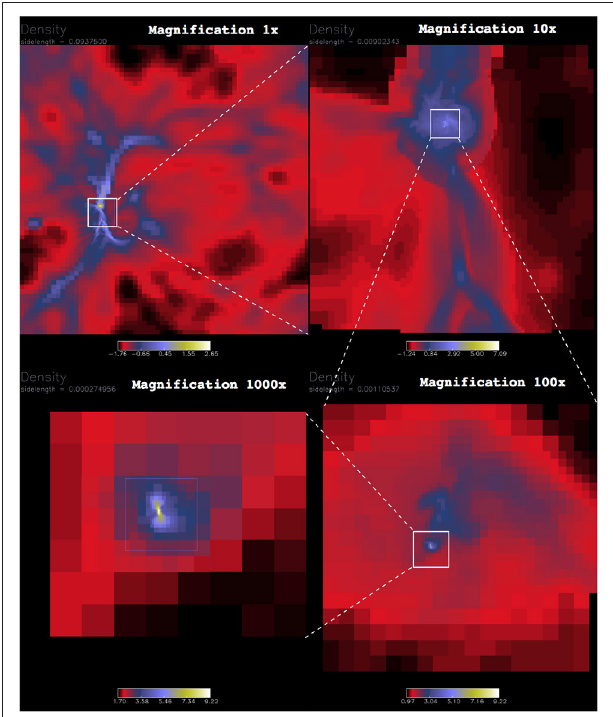
FIGURE 2 | The first published zoom-in image from a cosmological AMR simulation of primordial star formation. Reproduced by permission of Figure 1 from Norman and Bryan